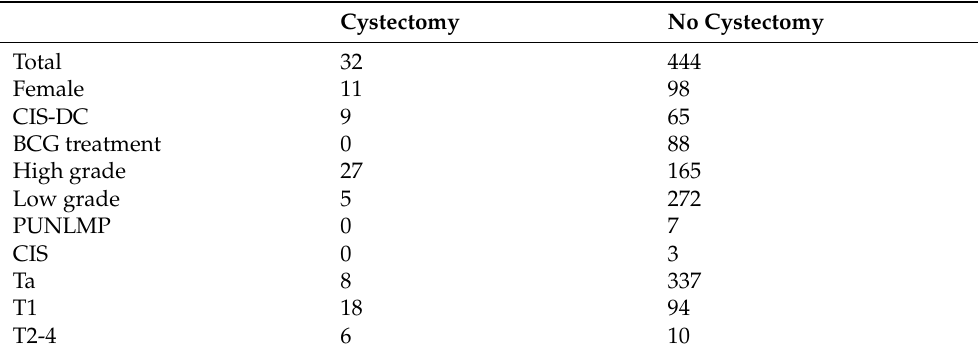
Table A3. Dataset characteristics per cystectomy (yes/no). BCG—Bacillus Calmette–Guérin vaccine. PUNLMP—papillary urothelial neoplasm of low-malignant potential. CIS—carcinoma in situ (in the